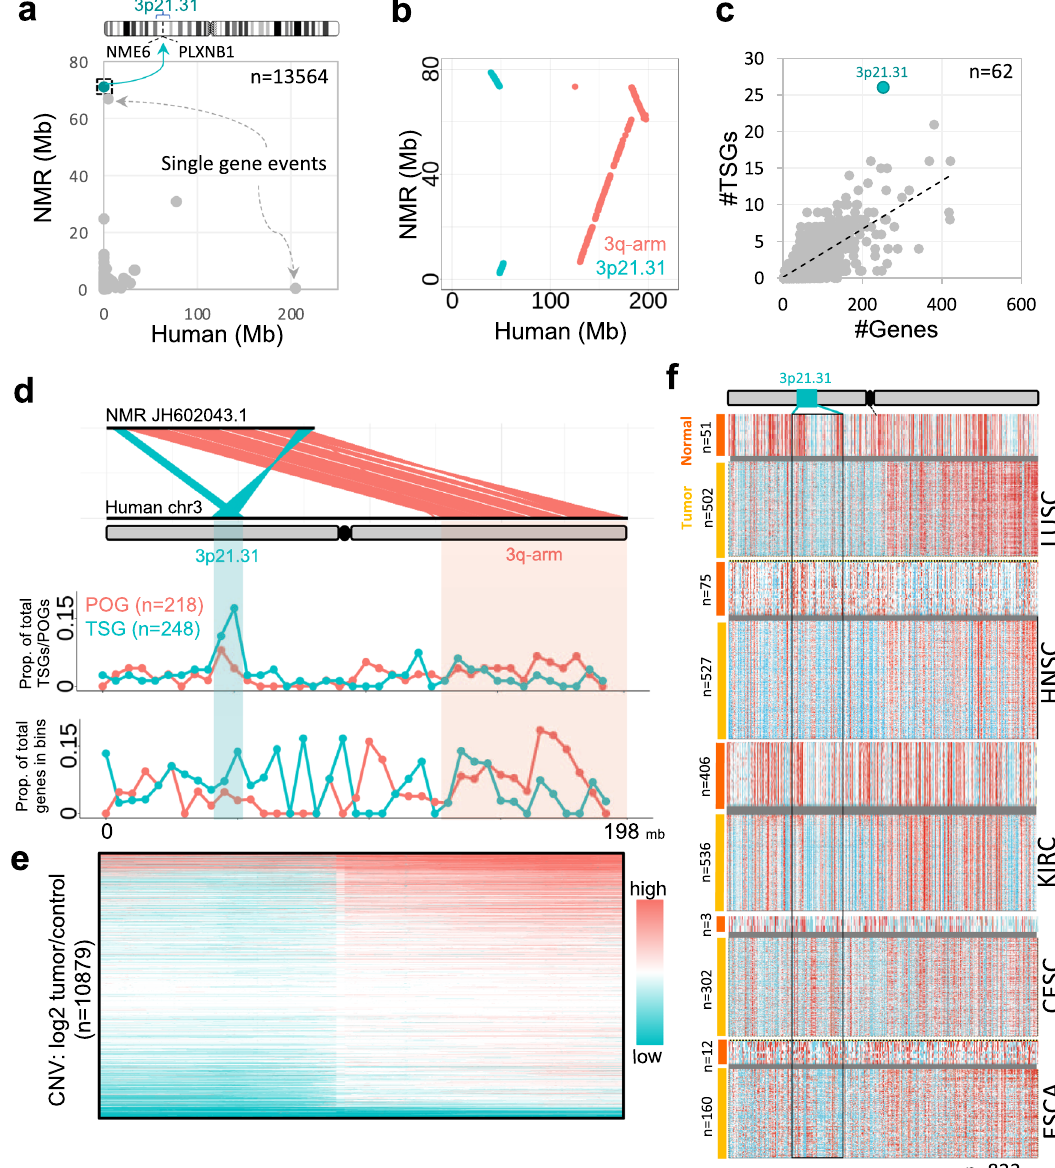
Fig. 1 Genomic rearrangements and tumour-suppressor properties of 3p21.31. a Scatter plot of all intergenic distances between consecutive genes of human vs. that of corresponding NMR orthologues. The box on the y axis highlights the genes (NME6 and PLXNB1) that were proximal in human, but distant in NMR, and marks the large genomic split of 3p21.31 locus. The events of single-gene repositioning are marked by grey arrows. Details of these events are given in Supplementary Fig. 1a, b. b Dot plot between human chr3 and NMR JH602043.1 scaffold. Sea-green coloured dots represent 3p21.31 locus, while the 3q arm of chr3 is shown in red. c Number of tumour- suppressor genes as a function of the total number of genes in each chromosomal band of human genome. The 3p21.31 cluster is marked in sea-green colour. d Upper panel: linear view of genomic rearrangements between human chr3 and NMR JH602043.1. Middle and lower panels: density of proto-oncogenes and tumour-suppressor genes along human chr3, normalised by the total number of TSGs and POGs (upper panel), and by the total number of genes in respective chromosomal bands (lower panel). e Copy number variations along human chr3 in TCGA Pan-cancer dataset ( n = 10,879). Each horizontal line represents one instance of CNV, each row represents one patient, and the colour grade scales to the tumour-to-control ratio of genomic DNA in TCGA Pan-Cancer dataset. f Gene expression (RNA-seq data normalised to TCGA cohort) of tumour and normal tissues along chromosome 3. Data shown in panels e and f were directly obtained from UCSC Xena browser. LUSC lung squamous cell carcinoma, HNSC head – neck squamous cell carcinoma, KIRC kidney renal clear cell carcinoma, CESC cervical squamous cell carcinoma and endocervical adenocarcinoma, ESCA oesophageal